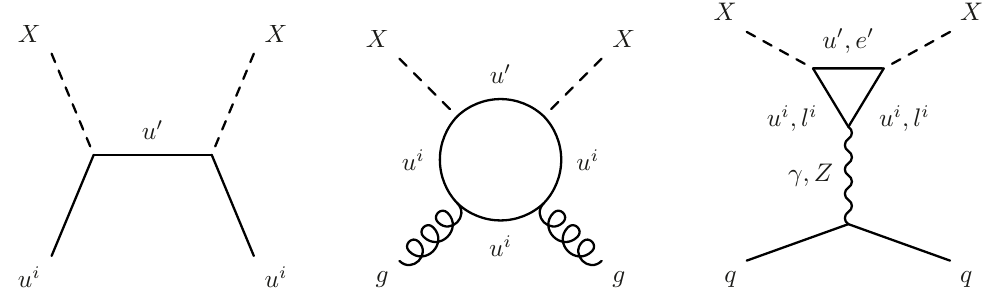
Figure 1 . Example diagrams relevant for DM-nucleus elastic